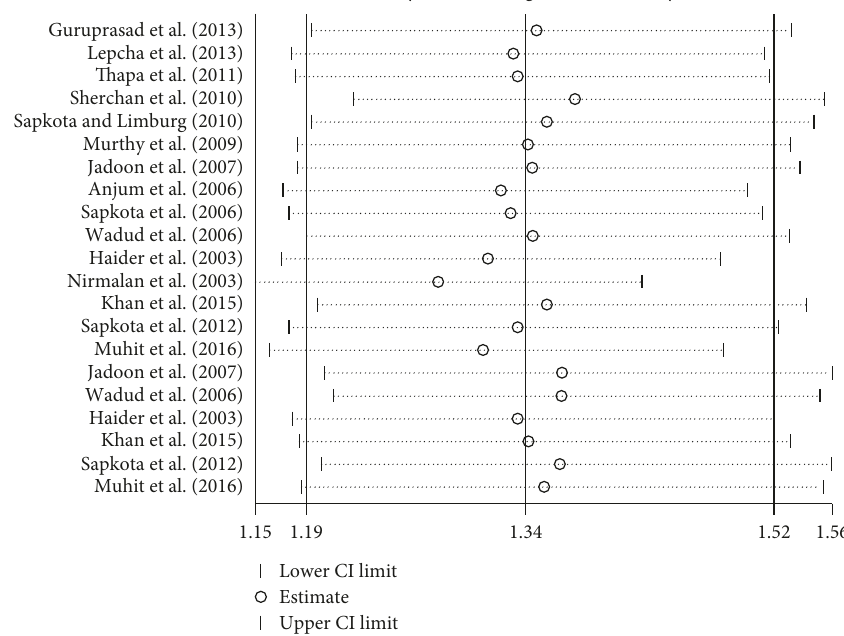
Figure 14: Sensitivity analysis of CSC on a person. CSC � cataract surgical coverage; CI � confidence